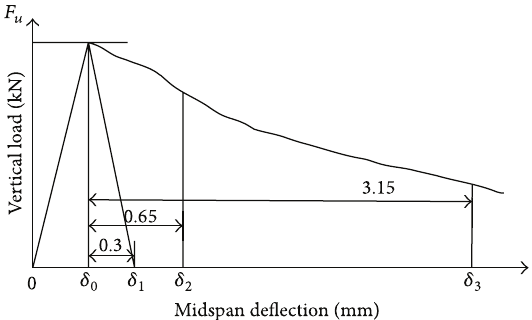
Figure 4: Calculation diagram for flexural toughness of DBV